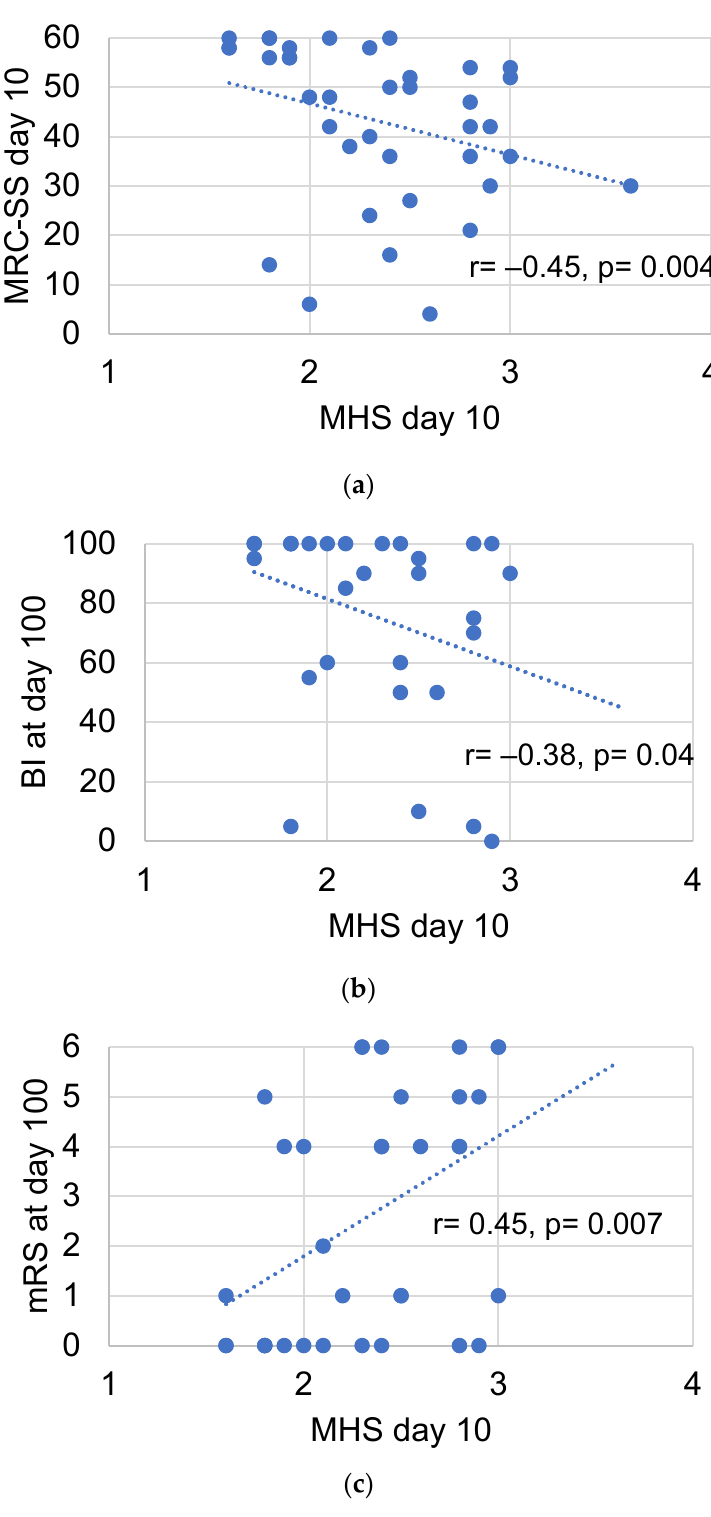
Figure 5. Correlation of the MHS with clinical outcome parameters. Correlation of the MHS on day 10 with the MRC-SS on day 10 ( a ), the BI ( b ) and the mRS on day 100 ( c ). BI: Barthel index. MHS: global mean Heckmatt score. MRC-SS: Medical Research Council sum score. mRS: Modified Rankin scale. r: correlation coefficient.